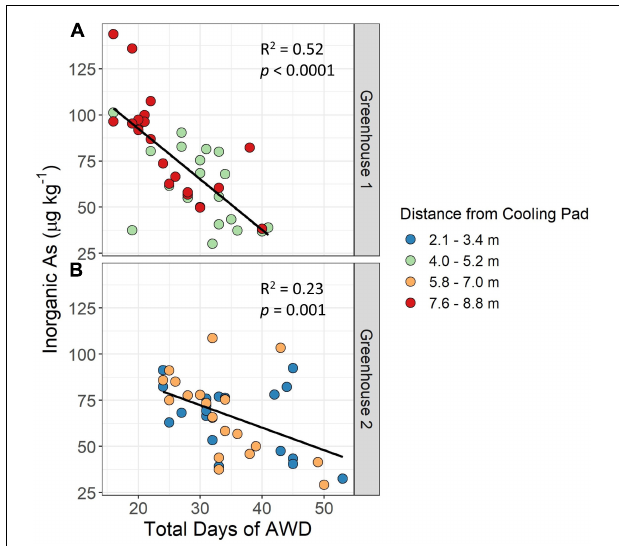
FIGURE 5 | Impact of days under AWD on grain inorganic As levels. Brown rice inorganic As accumulation in response to the total number of days to achieve the target soil volumetric water content (VWC) using alternate wetting and drying (AWD) cycles (e.g., sum of the total days under AWD for cycles 1 and 2) and distance of experimental units from the greenhouse cooling pad. In greenhouse 1 (A) the AWD tables were farther from the cooling pad than in greenhouse 2 (B) .